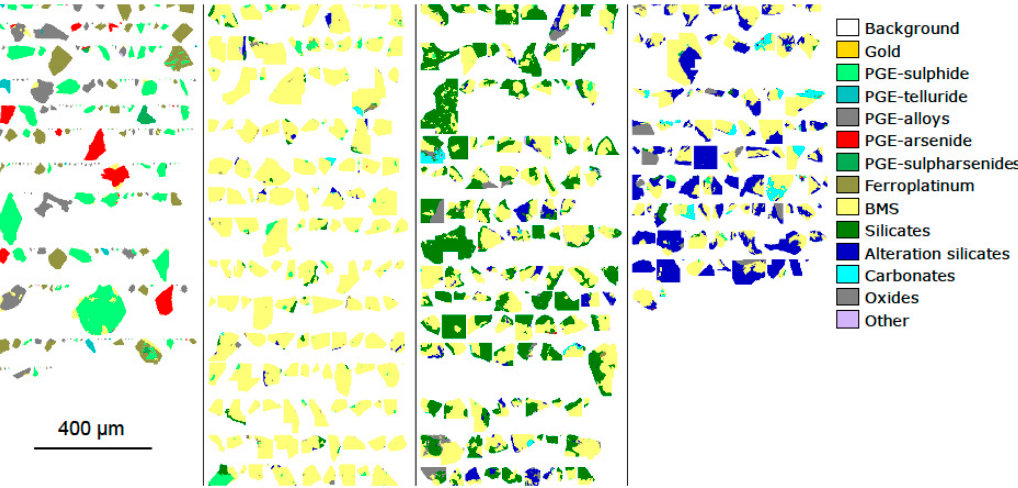
Figure 14. MLA false-color images of the various mineral particles in the gravity concentrate. The first column shows the liberated platinum-group minerals, the second column some examples of sulphides and associated platinum-group minerals, and columns 3 and 4 the various silicate and oxide minerals (many with associated sulphides). Note that some of the larger particles totally fill the field of view, hence their square nature.